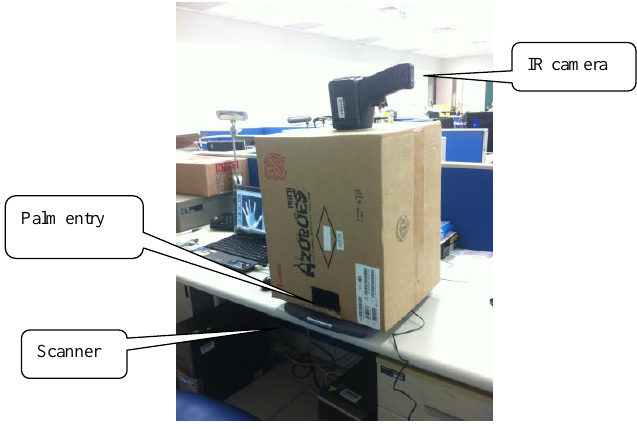
Figure 14. The configuration of the image collection system.